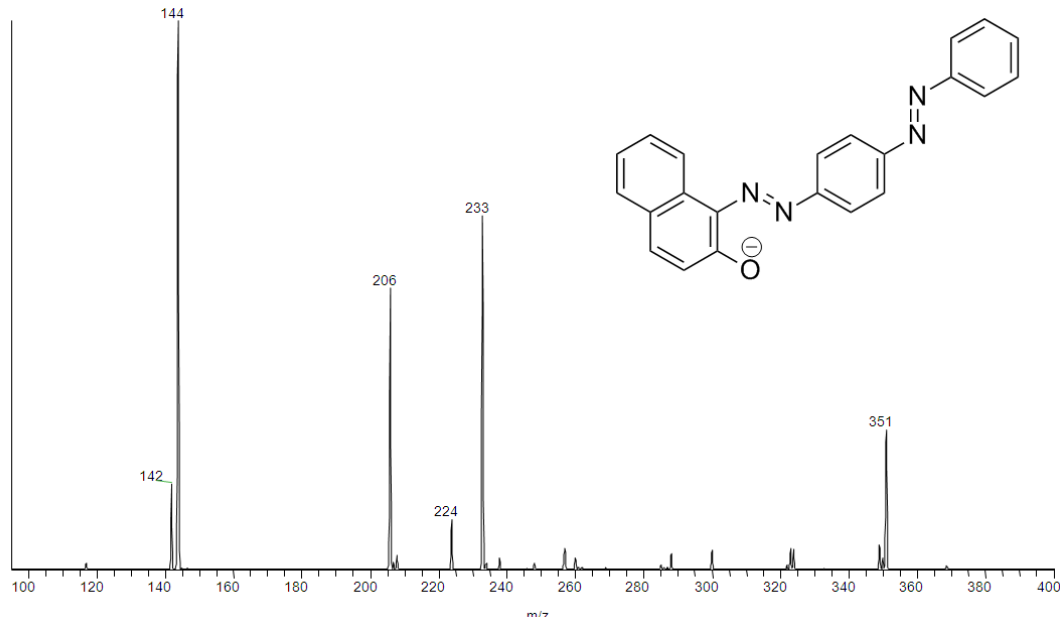
Figure 7. MS/MS spectrum of ion on m/z 351—[M − H] − identified as Sudan